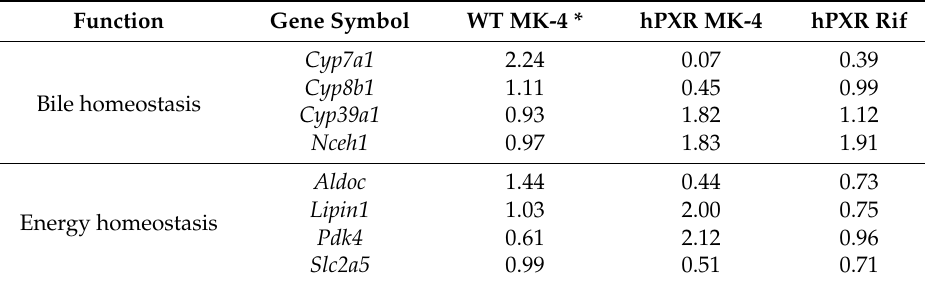
Figure 3. Venn diagram of differentially expressed genes in mice treated with rifampicin, menaquinone-4, and control mice. ( A – C ) Genes that were ( A ) upregulated (more than twice), ( B ) downregulated (to below 0.5-fold), or ( C ) overall differentially expressed after the treatment with rifampicin (Rif) or menaquinone-4 (MK-4) in comparison with the levels in control (Cont) hPXR mice. Overall, there were 29 shared differentially expressed genes between Rif- and MK-4 treated groups (eight upregulated and 21 downregulated). Five hundred and two genes (135 upregulated and 367 downregulated) and 590 genes (299 upregulated and 291 downregulated) differentially expressed genes were unique for Rif- and MK-4 treated hPXR mice, respectively. ( D – F ) Genes that were ( D ) upregulated (more than twice), ( E ) downregulated (to below 0.5-fold), or ( F ) overall differentially expressed in comparison with the levels in control (Cont) WT and hPXR mice. Overall, there were 26 shared differentially expressed genes between MK-4 treated hPXR and WT groups (nine upregulated and 17 downregulated). Five hundred and ninety-three (298 upregulated and 295 downregulated) and 437 (257 upregulated and 180 downregulated) differentially expressed genes were unique for MK-4 treated hPXR and WT mice, respectively. Table 3. Comparison of fold changes of gene expression levels (compared to corresponding control) in wild-type and hPXR